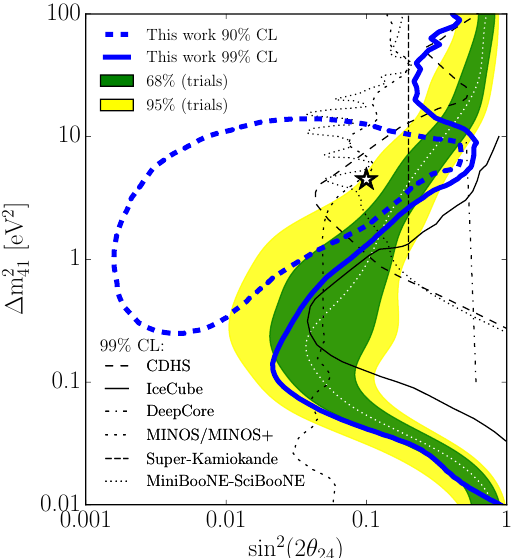
Figure 3. In blue solid (dashed): bound at 99% (90%) C.L. for the IceCube results of the search for sterile neutrinos [56]. To illustrate the results by CDHS [10,63], IceCube [60], DeepCore [53], Minos/Minos+ [64], Super-Kamiokande [7], and MiniBooNE-SciBooNE [3,9,65] are shown. The star marks the analysis best-fit point location. Figure from [56].